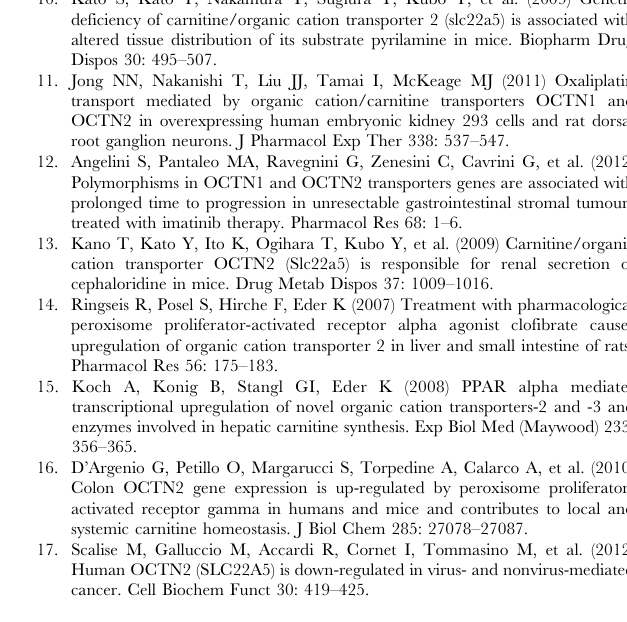
Figure S1 Methylation profiles around the transcriptional start site of OCTN2 in LS174T cells. DNA was extracted and subjected to bisulfite modification. Bisulfite modified DNA was amplified by BSP and sequenced as described under Materials and methods . Pointed star represents methylated CpG sites.